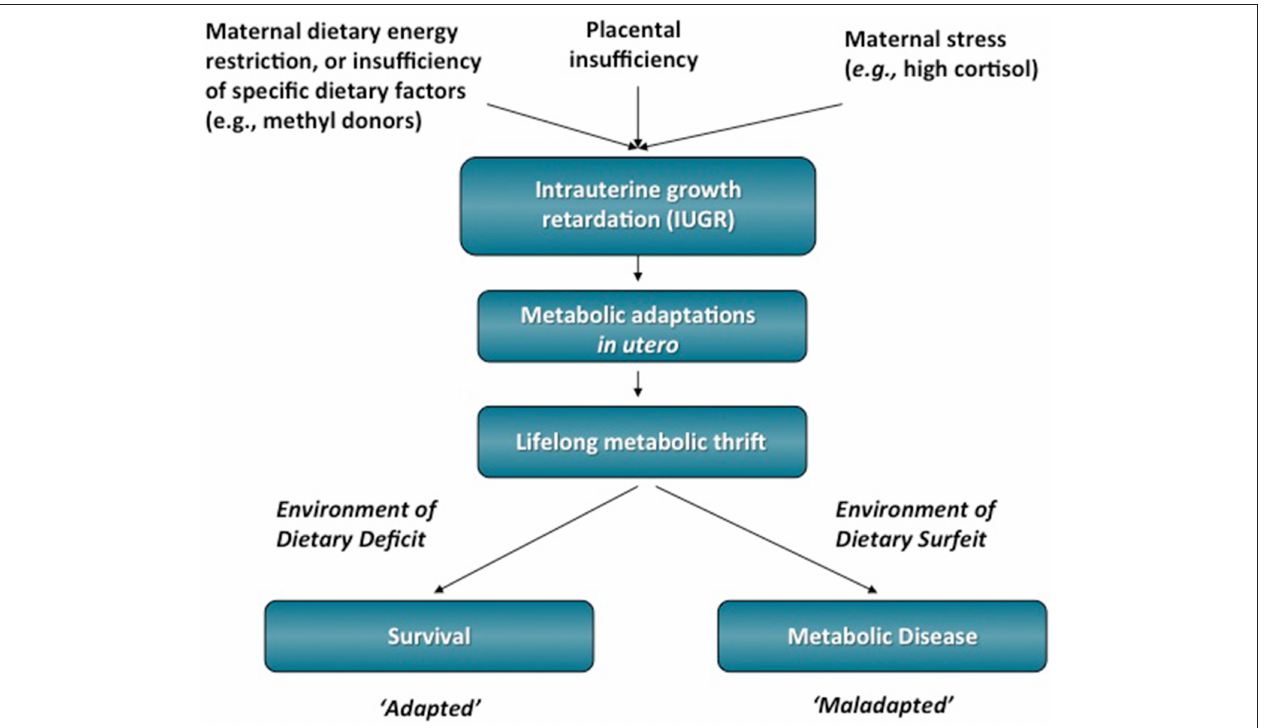
FIGURE 1 | IUGR is one environmental perturbation that has been linked to the development of T2DM and obesity in adulthood. It is hypothesized that the early life stressor of dietary energy restriction may program metabolic adaptations that favor survival initially, but are ultimately detrimental to adult health in an environment of dietary energy surfeit. Therefore, what was an advantage in utero in which energy substrates was scarce can become a disadvantage by increasing the person’s susceptibility to metabolic diseases in adulthood.